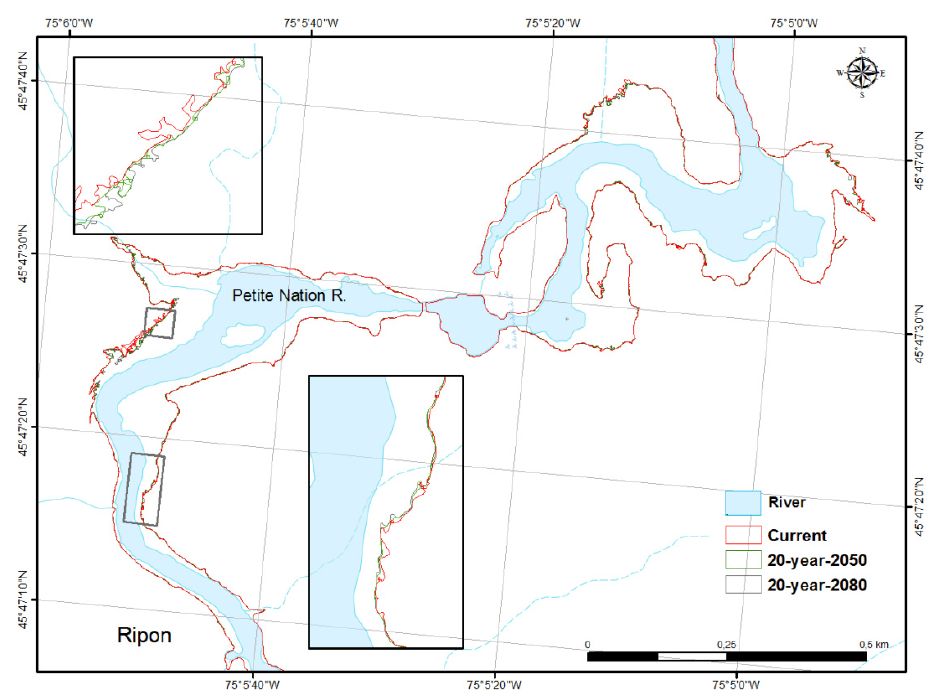
Figure A1. Flood extent for a 20-year return period, under current, 2050, and 2080 horizons (RCP 8.5). Case: Ripon.